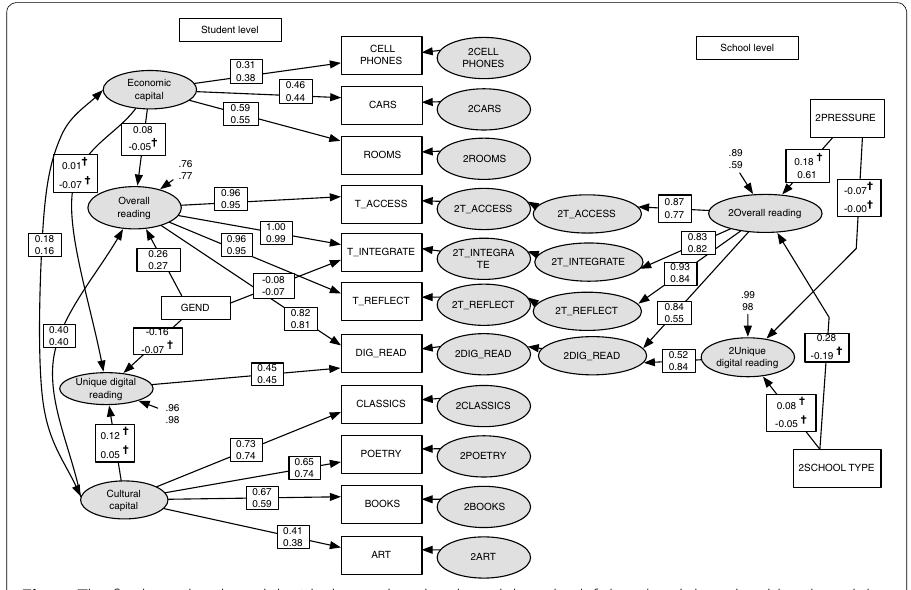
Fig. 4 The final two-level model with the student-level model on the left-hand and the school-level model is on the right-hand side . Norwegian estimates are placed below the Swedish estimates. A dagger indicates a non-significant